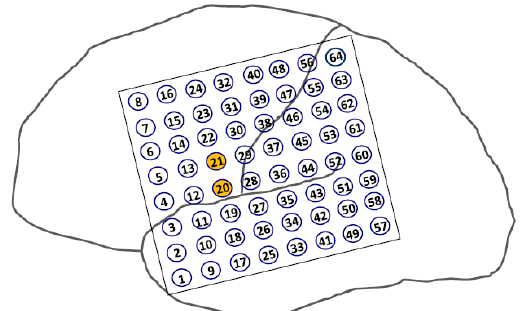
Figure 6. Stimulation cortical mapping. Electrodes 20 and 21, located in the prerolandic motor cortex, are stimulated based on a particular paradigm including slow titration of current density. The patient will be observed for any motor activity in the corresponding body part (face and hand) while engaged in a conversation or reading out loud.